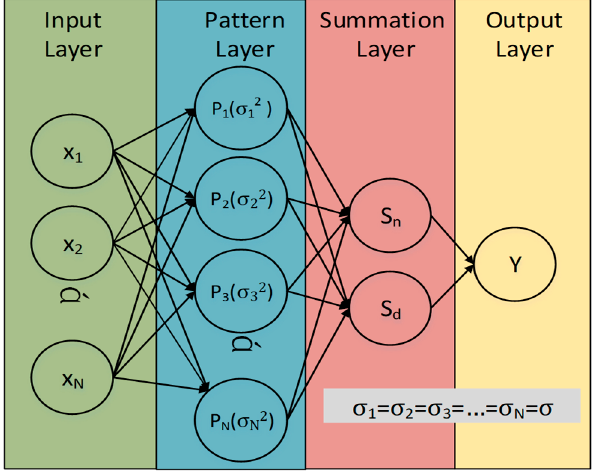
Figure 1. Standard generalized regression neural network (GRNN) block diagram.